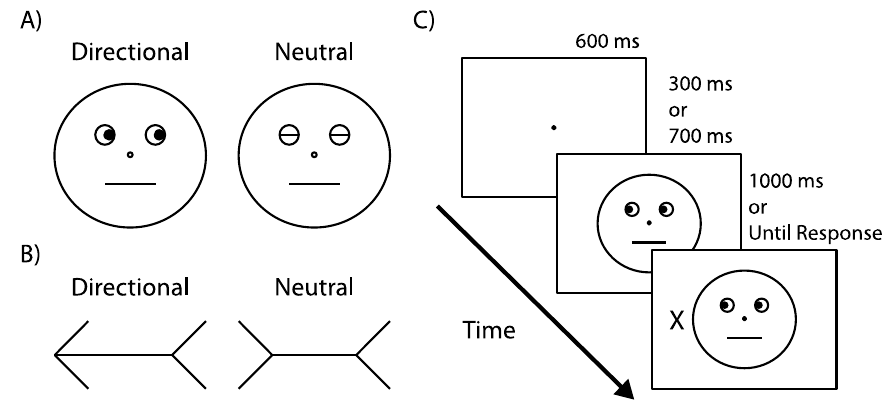
Figure 1. ( A ) Gaze cues; ( B ) Arrow cues; ( C ) Example trial sequence, illustrating a valid trial. All trials started with a 600 ms fixation display. Then a central cue, either a face or an arrow, was presented. After 300 or 700 ms, a response target, a capital letter ‘X’ or ‘O’, was shown at either the left or right peripheral location. Both the cue and the target remained on the screen until response or until the trial had timed out. Drawings are not to scale.